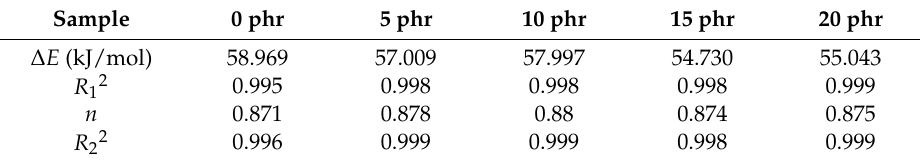
Table 1. Cure kinetic parameters and R2 of PSF/epoxy systems with different PSF